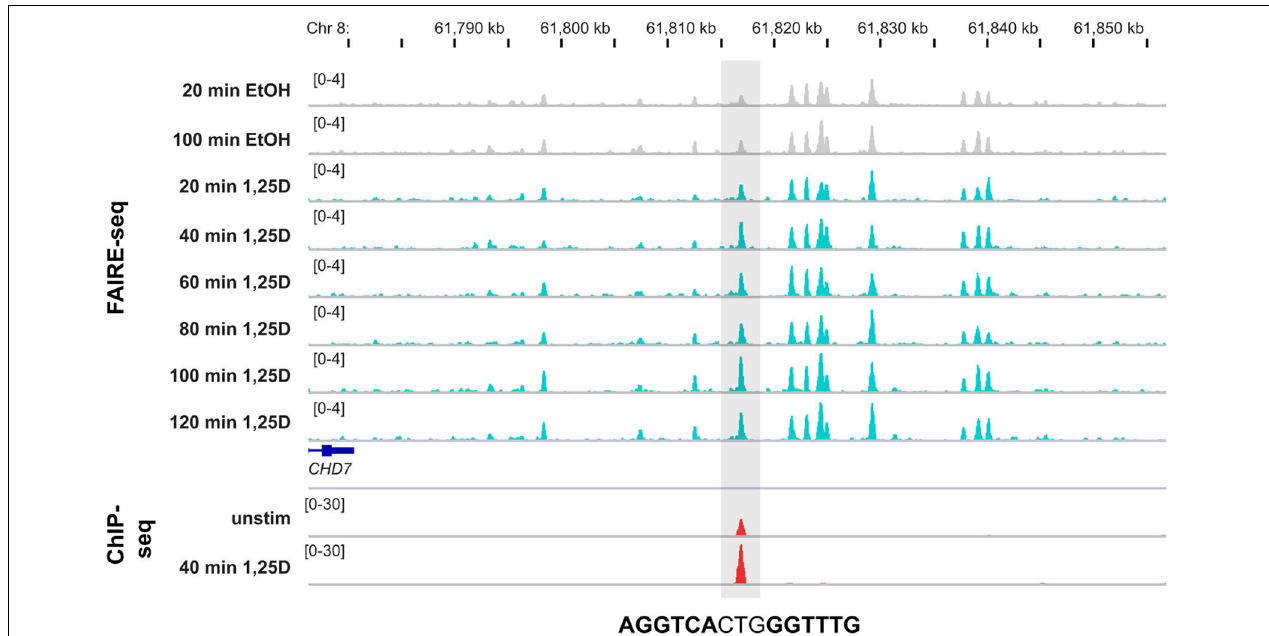
FIGURE 2 | Genomic view of 1,25(OH) 2 D 3 -dependent chromatin opening. The IGV browser visualizes the loci of a VDR locus 225kb downstream of the CHD7 gene ( ± 40kb of the peak summit). The peak tracks display data from THP-1 cells: a time course of FAIRE-seq data [gray for EtOH-treated controls and turquoise for